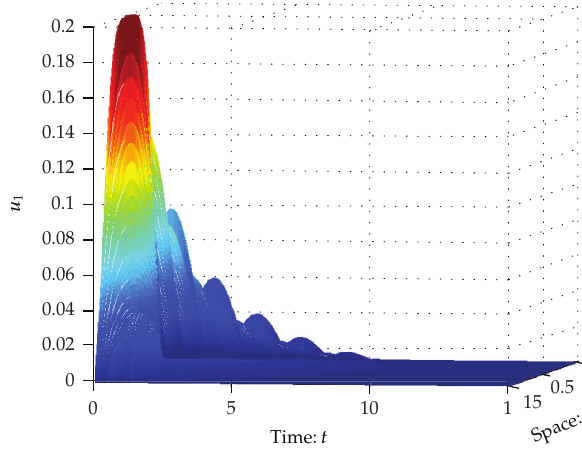
Figure 1: Computer simulation of the state u 1 (cid:3) t,x (cid:4) .